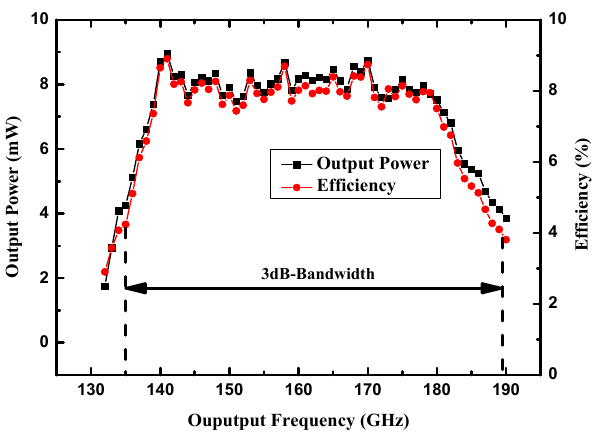
Figure 11. Measured efficiency and output power of the doubler under a self-bias resistor of 100 Ω .